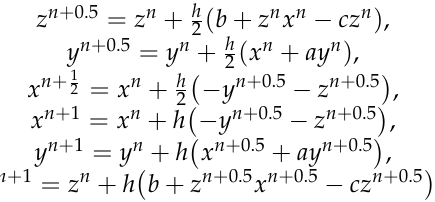
Table 3. D ependence between the total number of steps and tolerance while solving Rössler prob- lem.